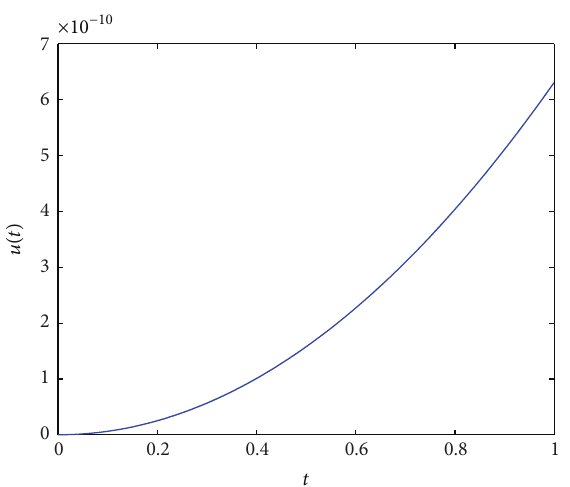
Figure1:ThedisplacementwithoutaWienerprocess,thenumerical simulation of (60), where 𝛼 = 1.5 , 𝛽 = 0.8 .